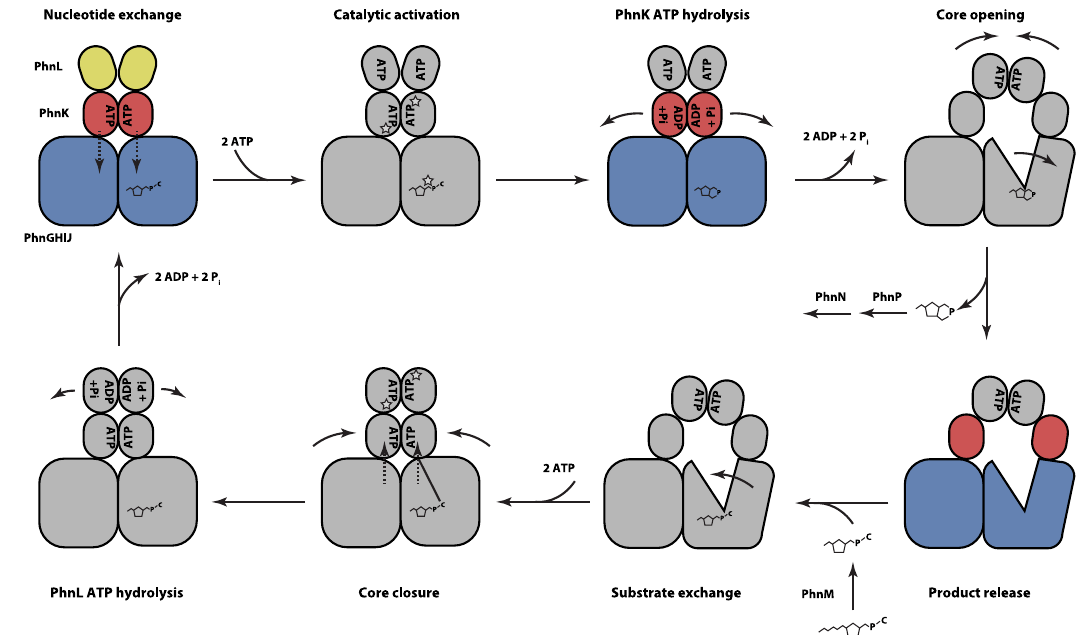
Fig. 6 | Model for the role of a double ABC module in catalysis by C – P lyase. A schematic model depicting a possible functional cycle for C – P lyase with known (observed)statesincoloursandputativestatesingrey.Atthetopleft,theC – Plyase core complex (PhnGHIJ, blue) binds two dimers of PhnK (red, in the ATP-bound state) and PhnL (partly open) as well as substrate. This complex can bind ATP in PhnL beforepossibly triggering a reaction in the core complex and ATP hydrolysis